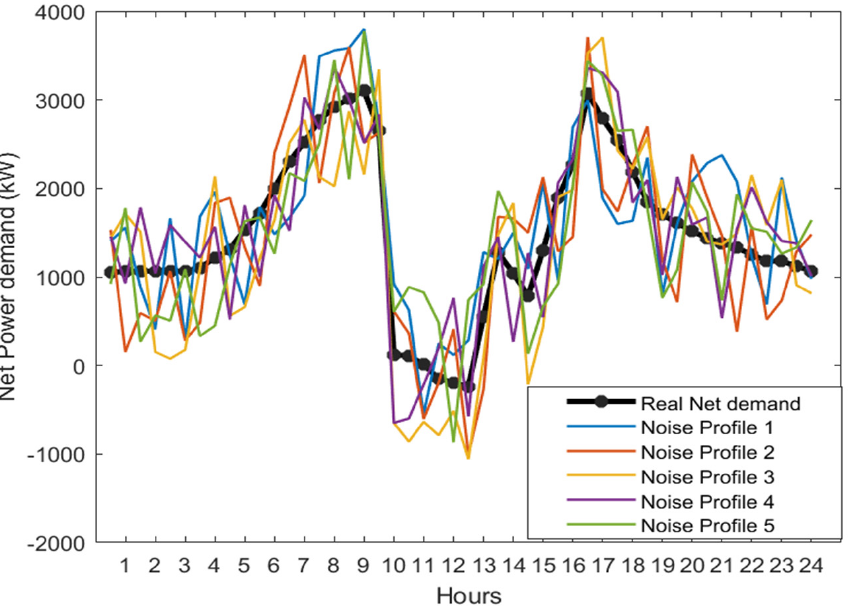
Figure 4. Real and forecasted net demand per hour for one day after noise addition (at σ =100).